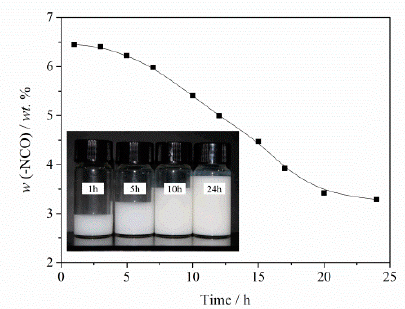
Figure 4. -NCO content in the emulsions via different standing time and their digital photos.